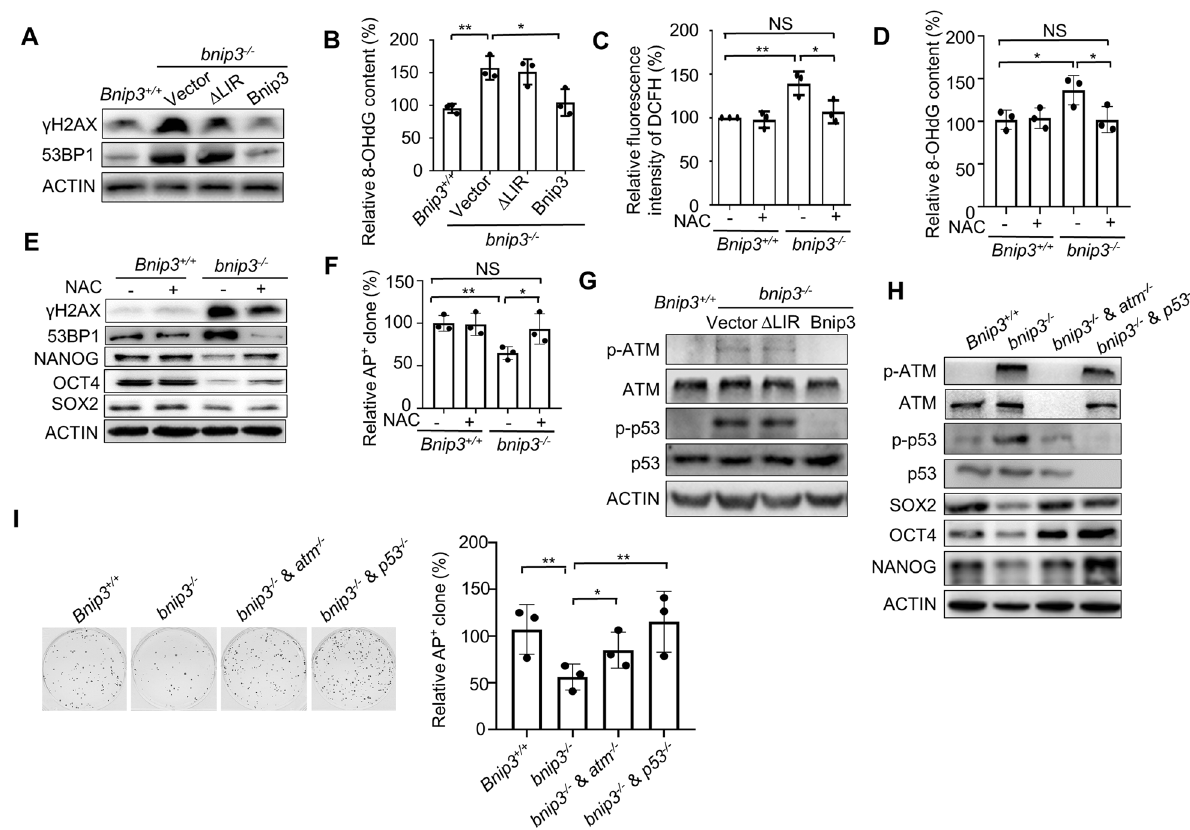
Fig. 2 BNIP3-dependent mitophagy protects ESC from oxidative stress-induced DNA damage. A Western blot of γ H2AX and 53BP1 in bnip3 − / − ESCs and rescued ESCs with actin as the loading control. B Increased cellular 8-OHdG in bnip3 − / − ESCs was rescued by gain